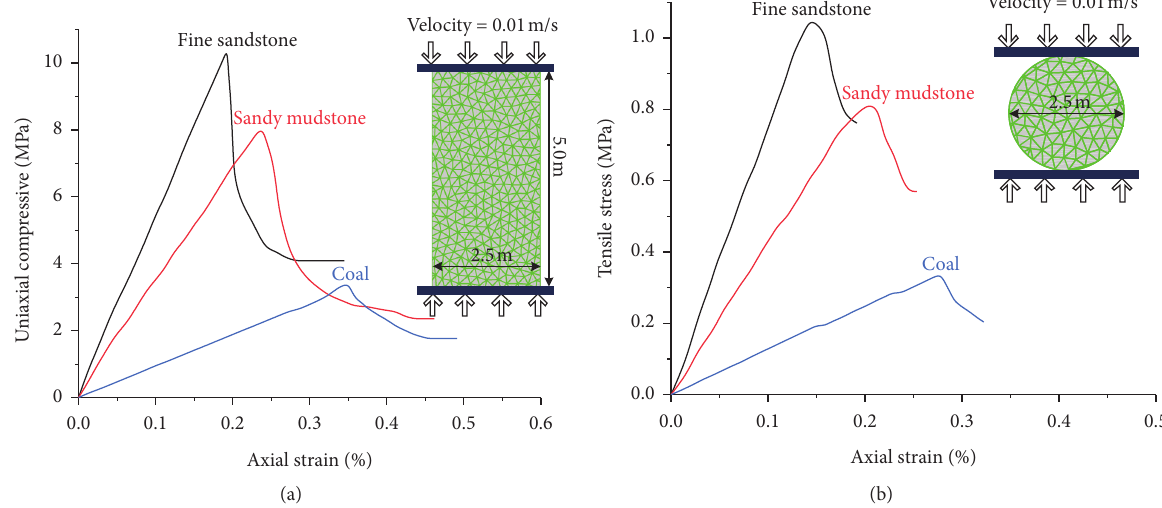
Figure 7: Calibration model using trigon logic: (a) calibrations for coal mass UCS; (b) Brazilian tensile test.